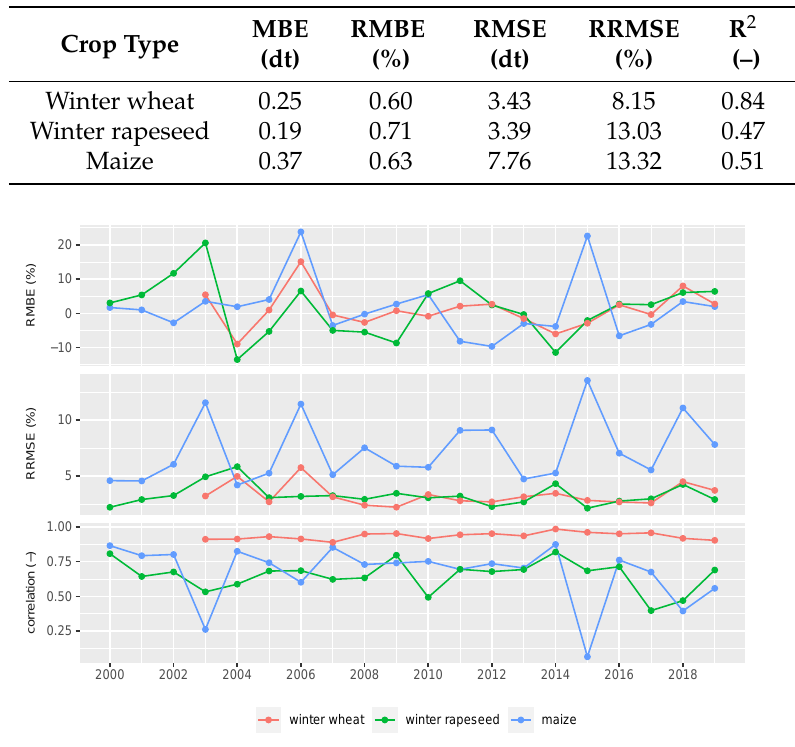
Figure 7. Map of crop yield forecasts performance at the NUTS-2 level. Table 3. Overall performance of crop yield forecasts at NUTS-2 level. MBE–Mean Bias Error, RMSE– Relative MBE, RMSE–Root Mean Square Error, RRMSE–Relative RMSE.